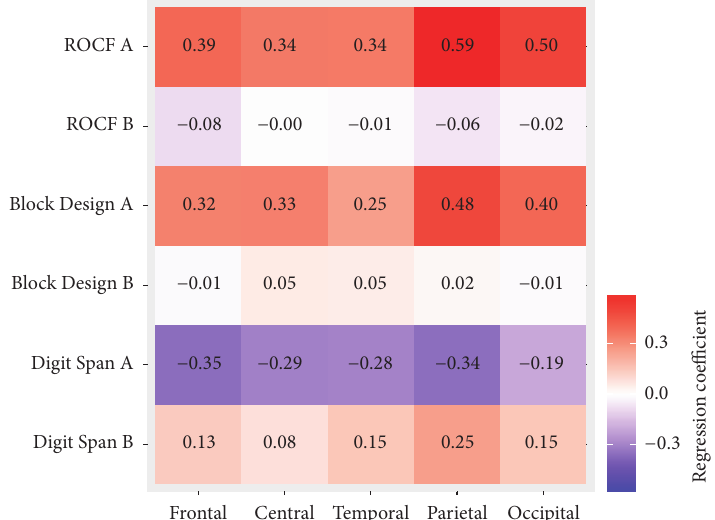
Figure 3: Correlation between alpha/theta ratio and tasks performance in different brain areas; ROCF is Rey-Osterrieth Complex Figure Test; A is group with lower tasks performance; B is group with higher tasks performance.